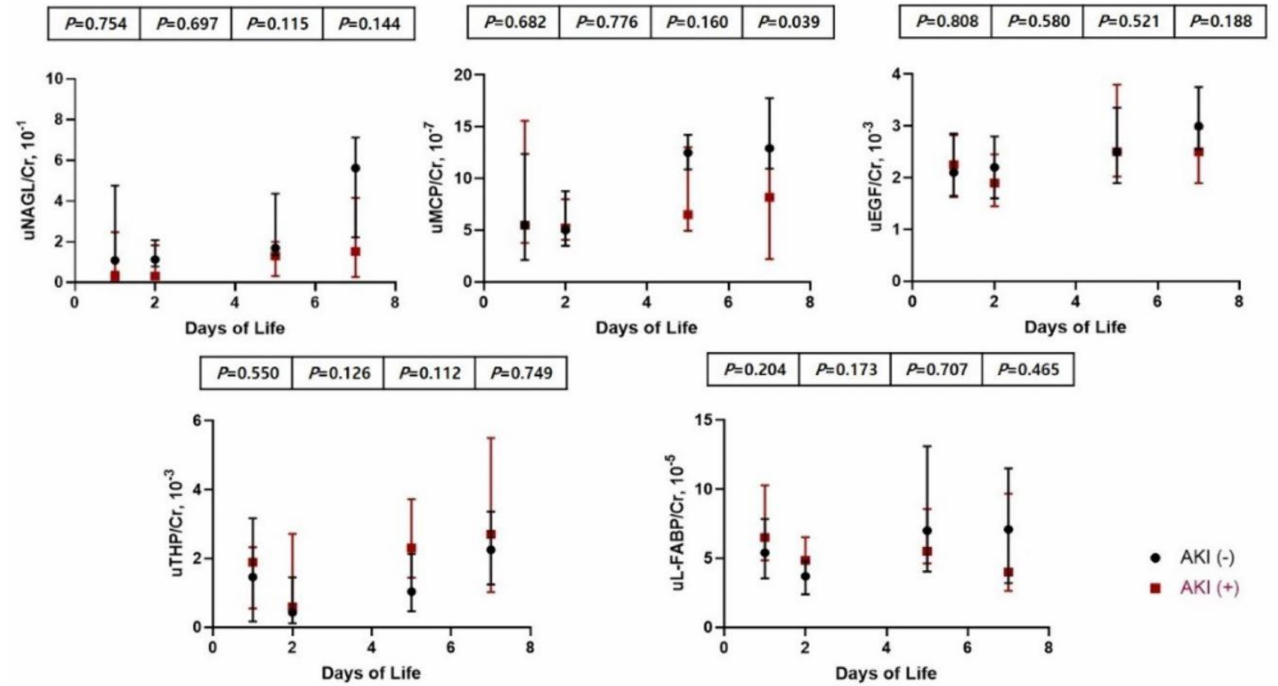
Figure 2. Comparison and changes in urinary biomarkers between infants with and without AKI. AKI, acute kidney